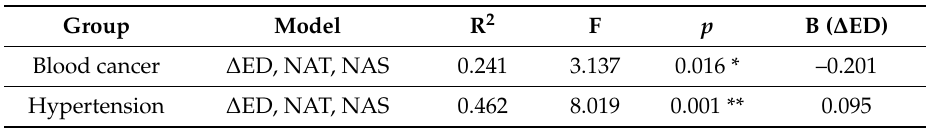
Table 15. Standard regression analysis summary for variables predicting Emotion Dysregulation (ED) in blood cancer and hypertension groups.